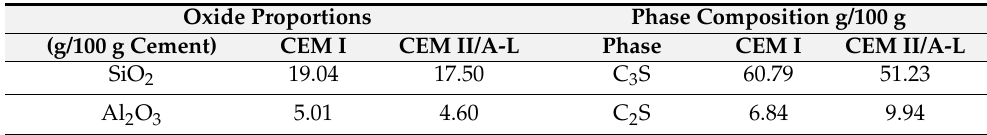
Table 1. Cement oxide proportions (from XRF) and clinker phase